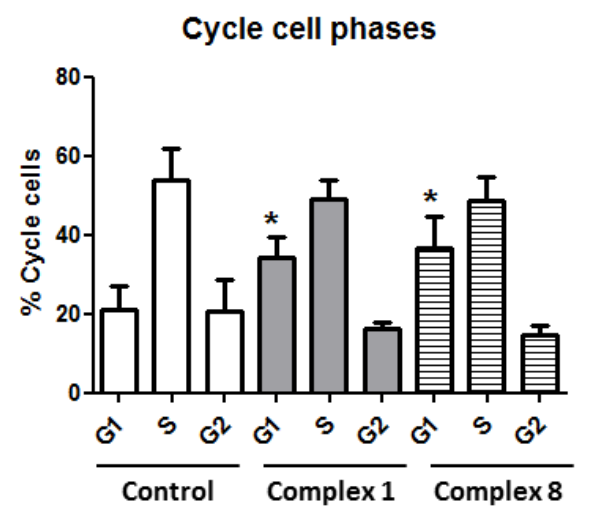
Figure 4. Percentages of the Caco-2 cycle cell phase studies by flow cytometry after incubation with complexes 1 (1.14 µM) and 8 (7.22 µM) for 48 and 72 h, respectively, with the distribution of the cells along the cell cycle phases. * p < 0.05 compared to the control.